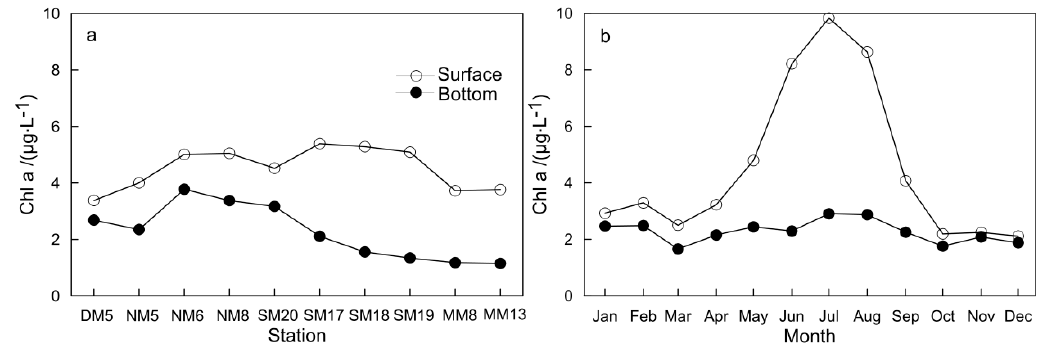
Figure 3. Variability of Chl a during the period 2000 − 2017. ( a ) Annual average at each station; ( b ) monthly average at all stations.